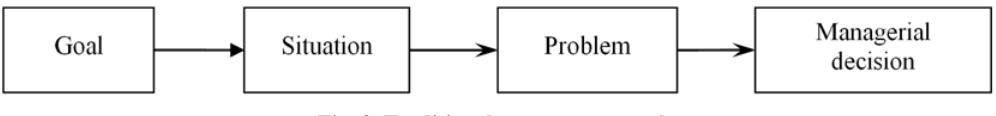
Fig. 3. Traditional management cycle